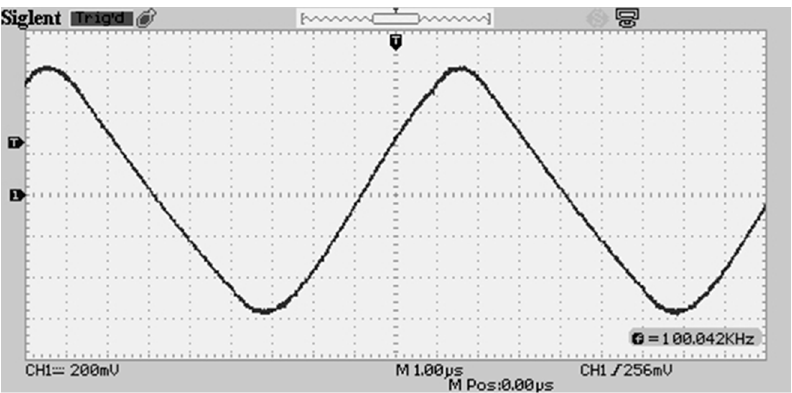
Figure 7. New waveform delivered to the sensing element.